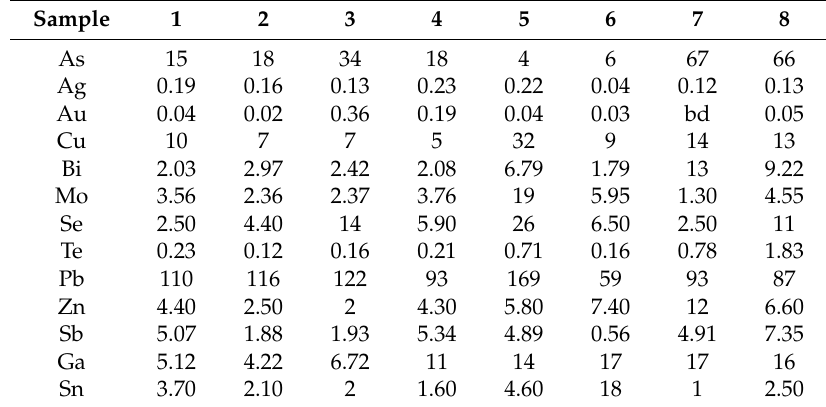
Table 4. Metallic element concentrations of samples from the high-sulfidation mineralization at the Konos Hill prospect, NE Greece (values in